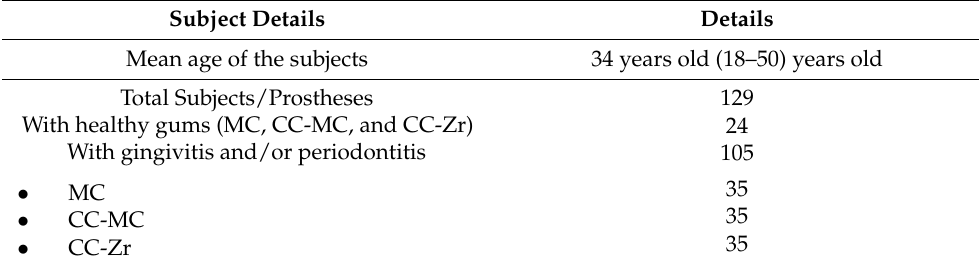
Table 1. Distribution of subjects in three groups according to their periodontal status.